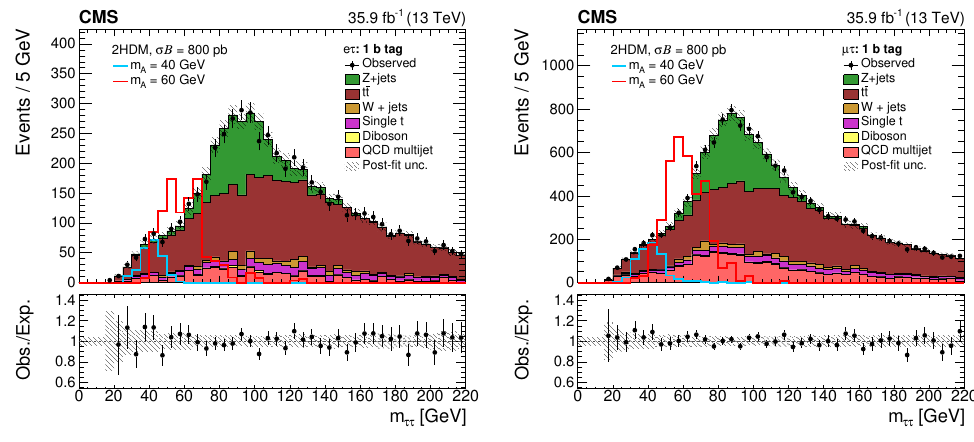
Figure 2 . Measured m distribution in the e t (left), and mt (right) channel, compared to the h h tt expected SM background contributions. The signal distributions for bbA with a pseudoscalar mass of 40 and 60 GeV are overlaid to illustrate the sensitivity. They are normalized to the cross section times branching fraction of 800 pb. The uncertainty bands represent the sum in quadrature of statistical and systematic uncertainties obtained from the (cid:12)t. The lower panels show the ratio between the observed and expected events in each